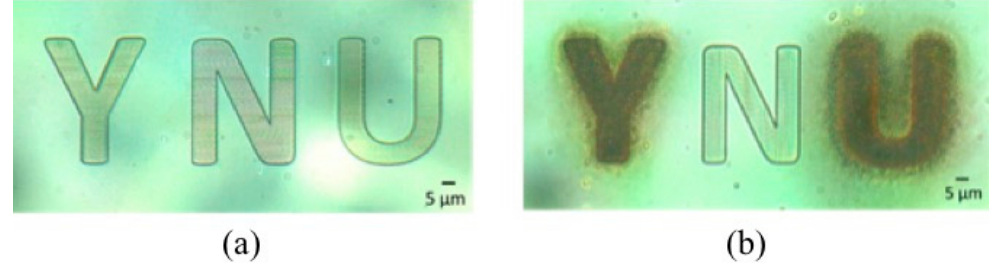
Figure 4. Optical images of selective magnetite coating of polymeric microstructures. ( a , b ) Optical images of the microstructures made from acrylic and methacrylic resin before and after electroless plating. The polymeric microstructure “N” made from methacrylic resin was not coated with magnetic materials.